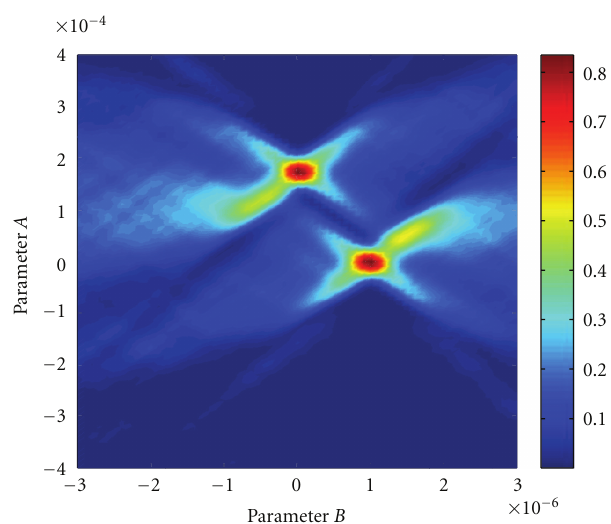
Figure 10: Correlated sources: Determination of parameters A and B based on semblance for a di ff ractor and a dipping reflector β = 20 0 . The black stars show the correct parameter